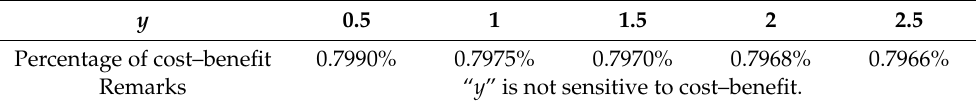
Table 8. Sensitivity of “ y ” to cost–benefit. The static input values of the parameters are: P = 5000,